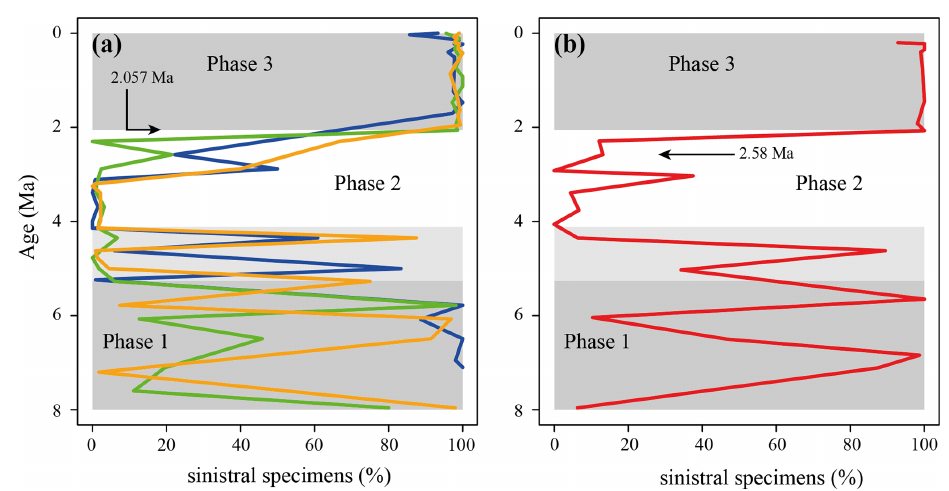
Figure 11. Percentage of sinistral specimens within the G. menardii population through time. (a) Tropical Atlantic Ocean Site 667 (green; this study), 502 (blue; Knappertsbusch, 2007b) and 925 (orange; Knappertsbusch, 2015). (b) Eastern tropical Pacific Ocean Site 503 (Knap- pertsbusch, 2007c). The grey areas represent the recognised phases as mentioned in the text. The lighter grey bar from 5.3Ma until ca. 4Ma shows the extended phase 1 for Sites 502, 503 and